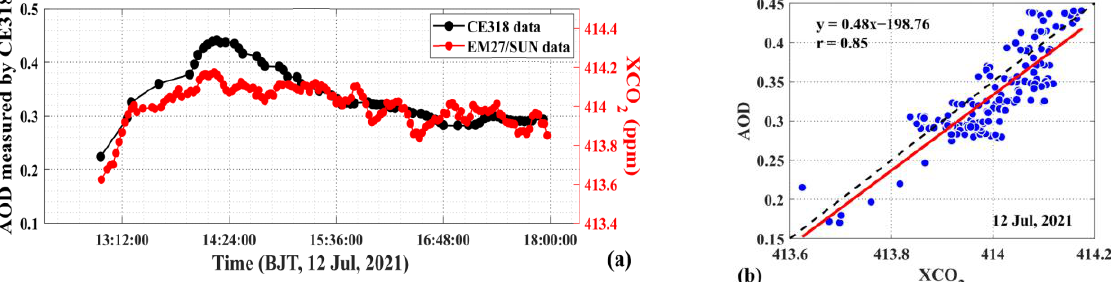
Figure 13. Measurement results of XCO 2 and AOD at the CRCS ground station on 12 July 2021 ( a ). The red dots represent the XCO 2 results measured by EM27/SUN, and the black scatter points represent the AOD results measured by CE318. ( b ) The correlation analysis result of XCO 2 and AOD.